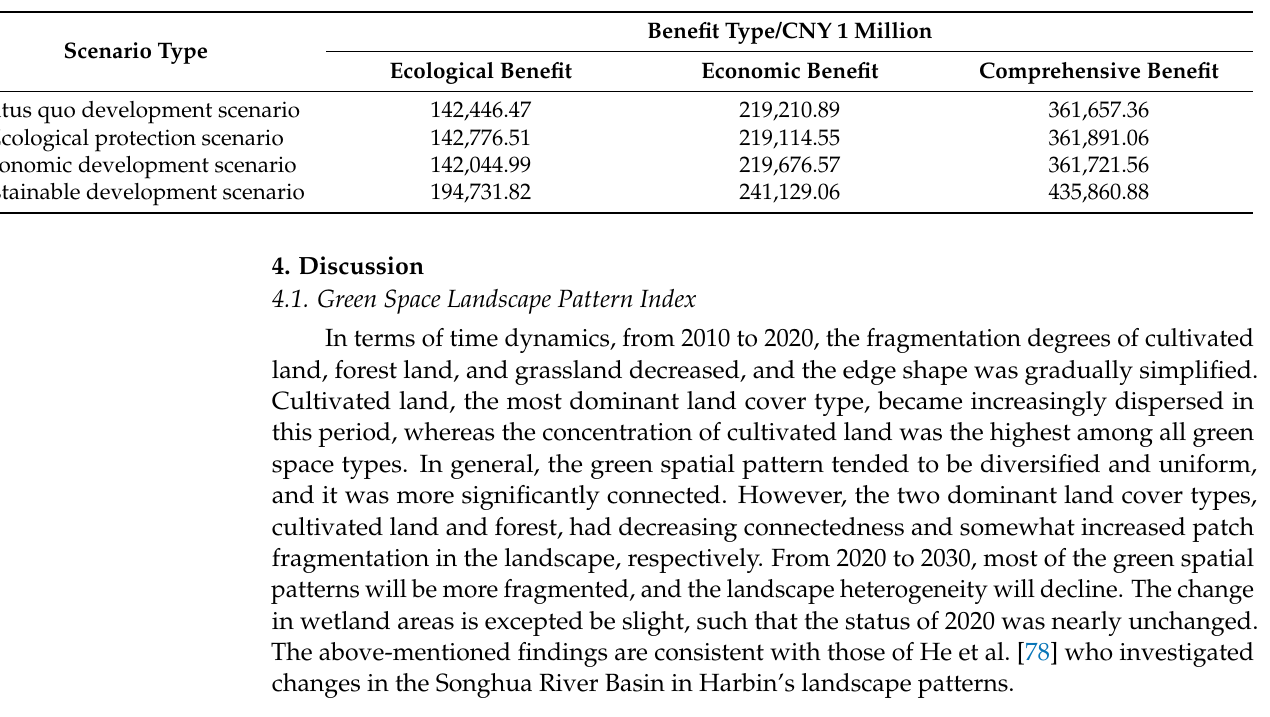
Table 7. Ecological benefit, economic benefit, and comprehensive benefit under different